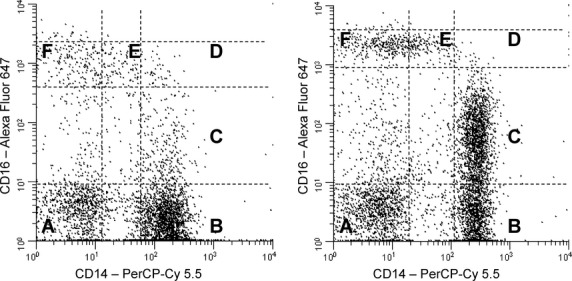
Two representative examples of CD14 and CD16 expression on monocytes (after forward‐/side‐scatter gating). CD14++ monocytes are contained in region B, CD14++16+ monocytes are in region C, CD14++16++ monocytes are in region D, and CD14+16++ monocytes are in region E. Region A contains cells that express neither CD14 nor CD16; region F contains cells that are CD16‐positive but CD14‐negative. Regions A and F were used for defining the other regions, as described in the Methods section.